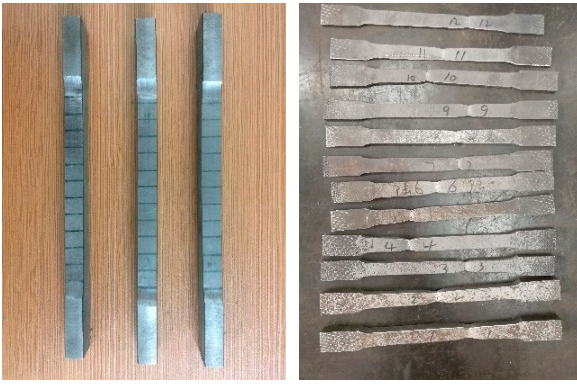
Figure 2. Test chart of steel properties. Table 2. Test data of steel properties.